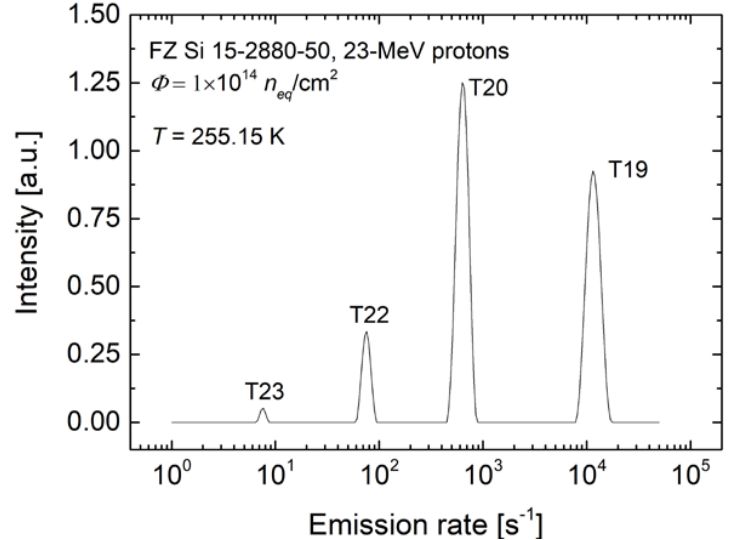
Figure 2. Laplace spectrum derived from the photocurrent relaxation waveform recorded at 255.15 K for a HPSi sample irradiated with a fluence of 1 × 10 14 n eq /cm 2 of 23-MeV protons. Four sharp peaks indicating the thermal emission rate values for the irradiation-induced deep traps labeled as T19, T20, T22, and T23 are visible.